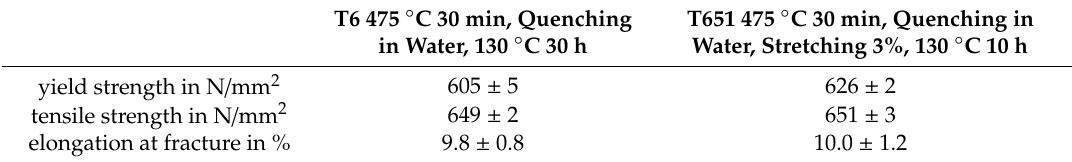
Figure 12. Mechanical properties of alloy 7068: With or without stretching 3%, di ff erent ageing times 1, 3, 10, and 30 h at 130 ◦ C. Table 2. Parameters from tensile testing: Heat treatment with or without